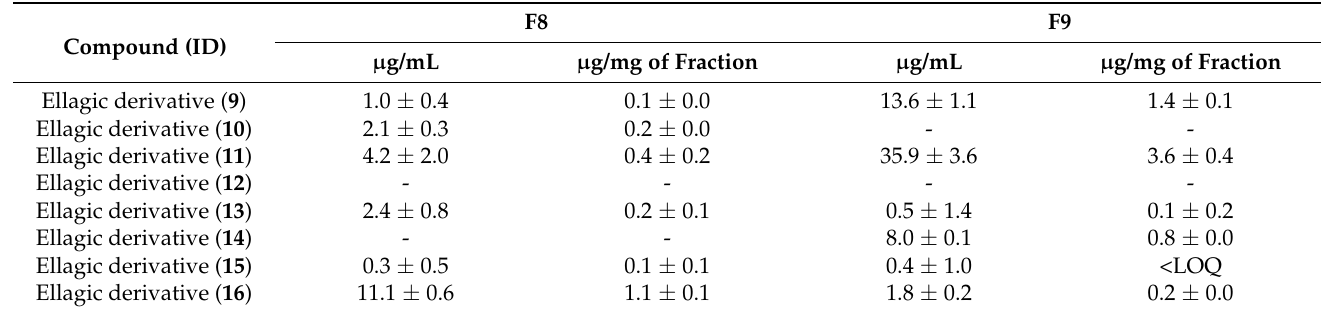
Table 4. Concentration of ellagic acid derivatives (in ellagic acid equivalents) in the two most active